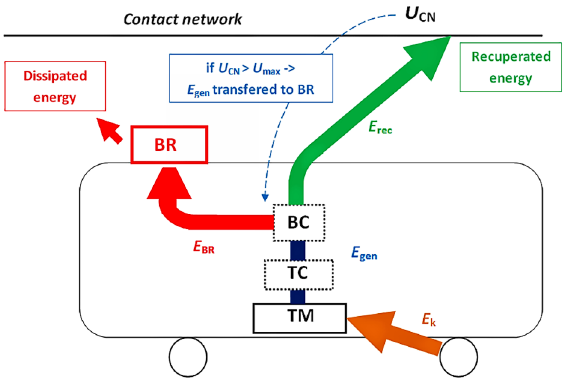
Fig. 12. Breaking energy low flow: U CN – voltage of contact supply network; E k – kinetic energy of vehicle; E gen – energy generated during breaking; E rec – energy recuperated to contact network; E BR – energy dissipated in breaking resistor; TM – traction motor; TC – traction controller; BC – breaking controller; RH – breaking